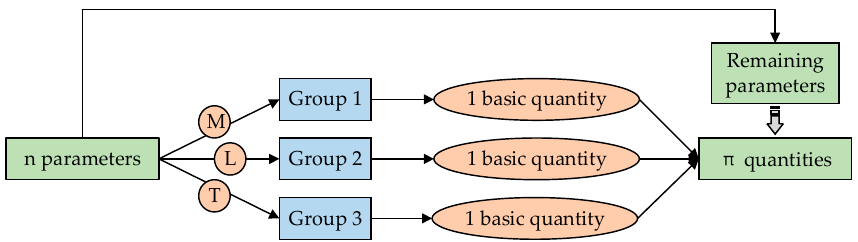
Figure 4. The basic quantity selection process.